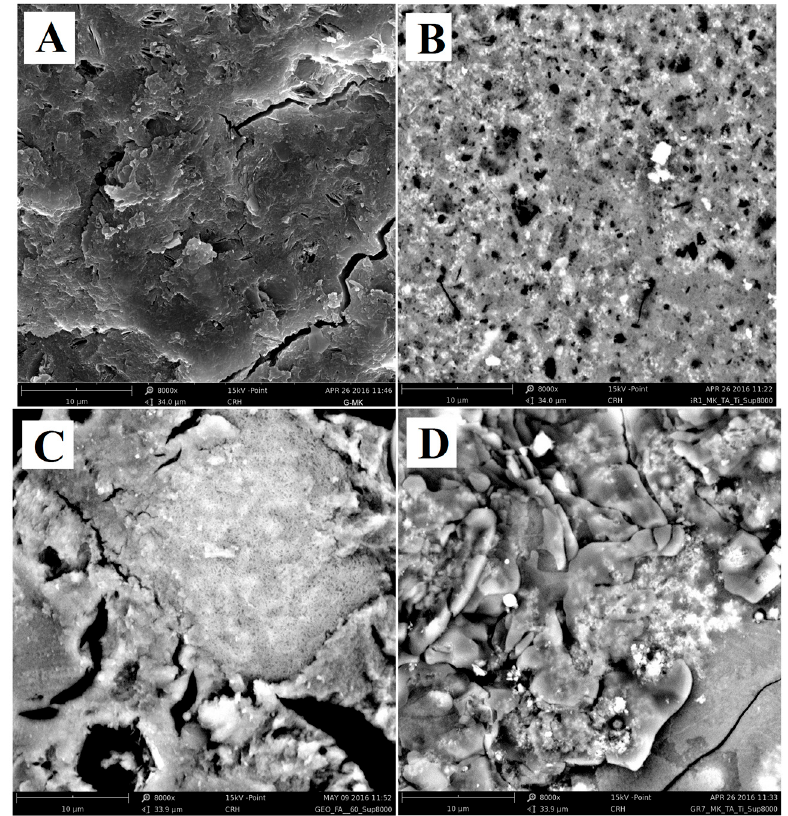
Figure 5. SEM images of surface at 8000 magnifications of the samples: ( A ) metakaolin-based geopolymer; ( B ) metakaolin (MK); ( C ) fly ash-based geopolymer; and ( D ) FA.